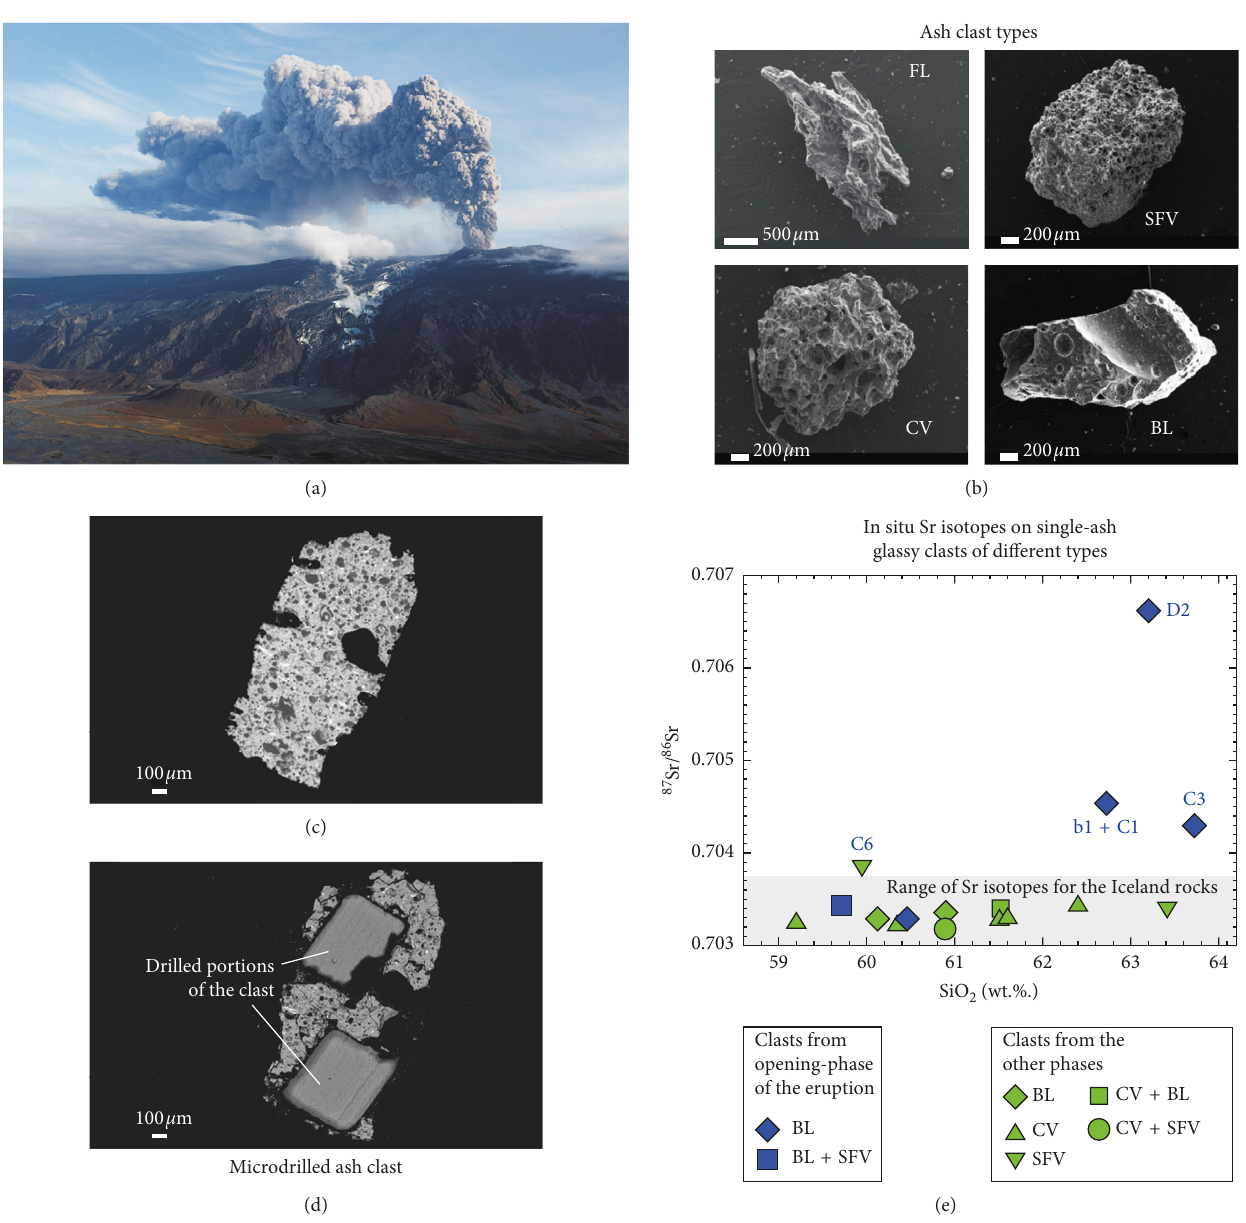
Figure 8: Results of micro-Sr isotopes in volcanic ash glasses of the 2010 explosive eruption of Eyjafjallaj¨okull volcano (Iceland). (a) Spectacular image of the ash cloud erupted by the volcano during the early stage of the 2010 activity (https://hiticeland.com/places_ and_photos_from_iceland/eyjafjallajokull causing); (b) back-scattered electron microscope images of different clast types sampled in the basal level of the fallout deposit related to the open phase of the 2010 eruption. FL vesicular; and BL blocky. Scale bars are in micron; comparison between back-scattered electron microscope images of clasts before (c) and (cid:31) after (d) in situ microdrilling. Scale bars are in micron; (e) 87 Sr/ 86 Sr versus SiO 2 (wt.%) diagram of matrix glasses sampled from single, glassy ash clasts. In situ microsampling for Sr-isotope determinations on glass and plagioclase have been obtained by microdrilling technique. Error bars are inside the